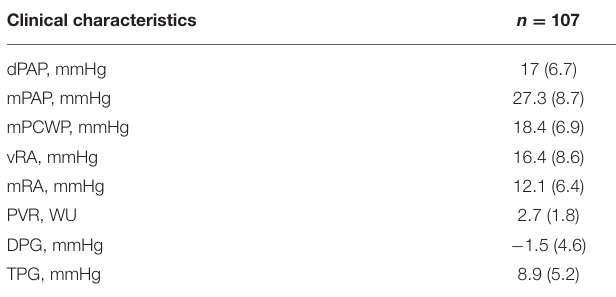
TABLE 1 | Baseline Characteristics for all patients. Clinical